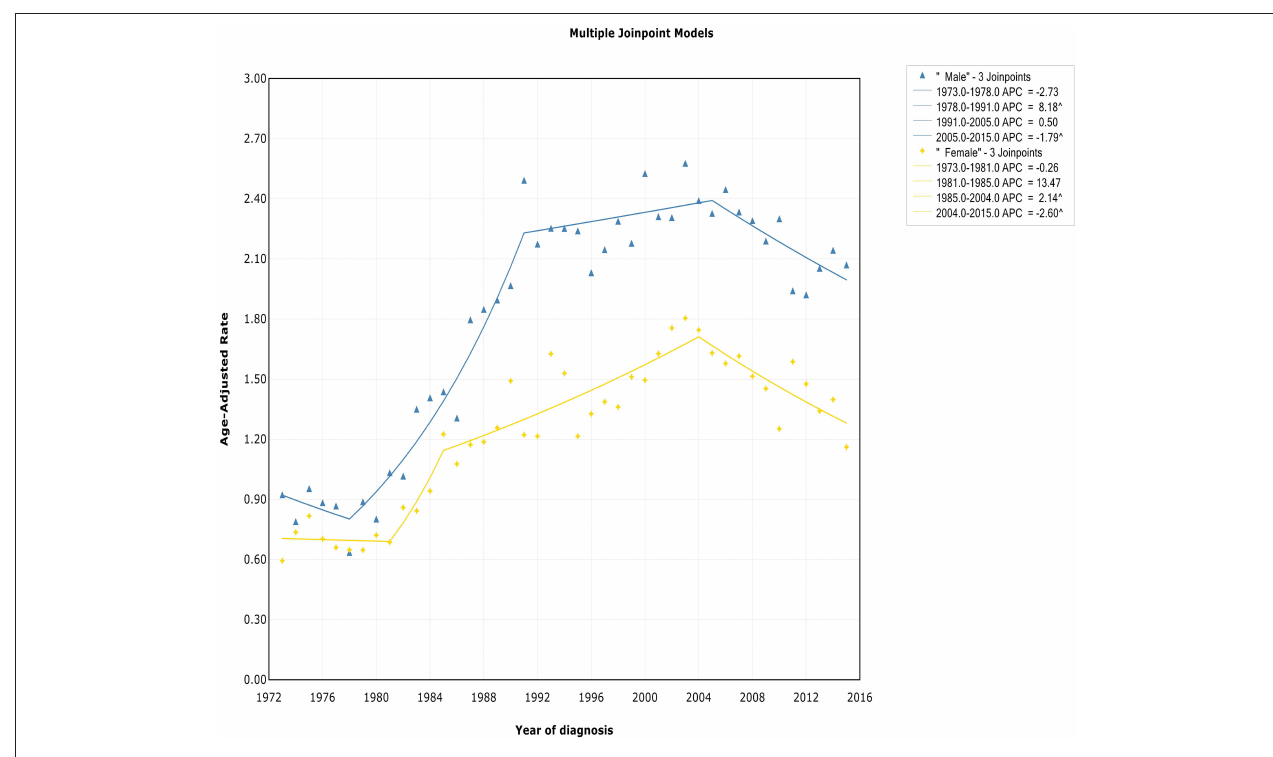
FIGURE 2 | Trends of annual incidence of extranodal DLBCL according to gender.